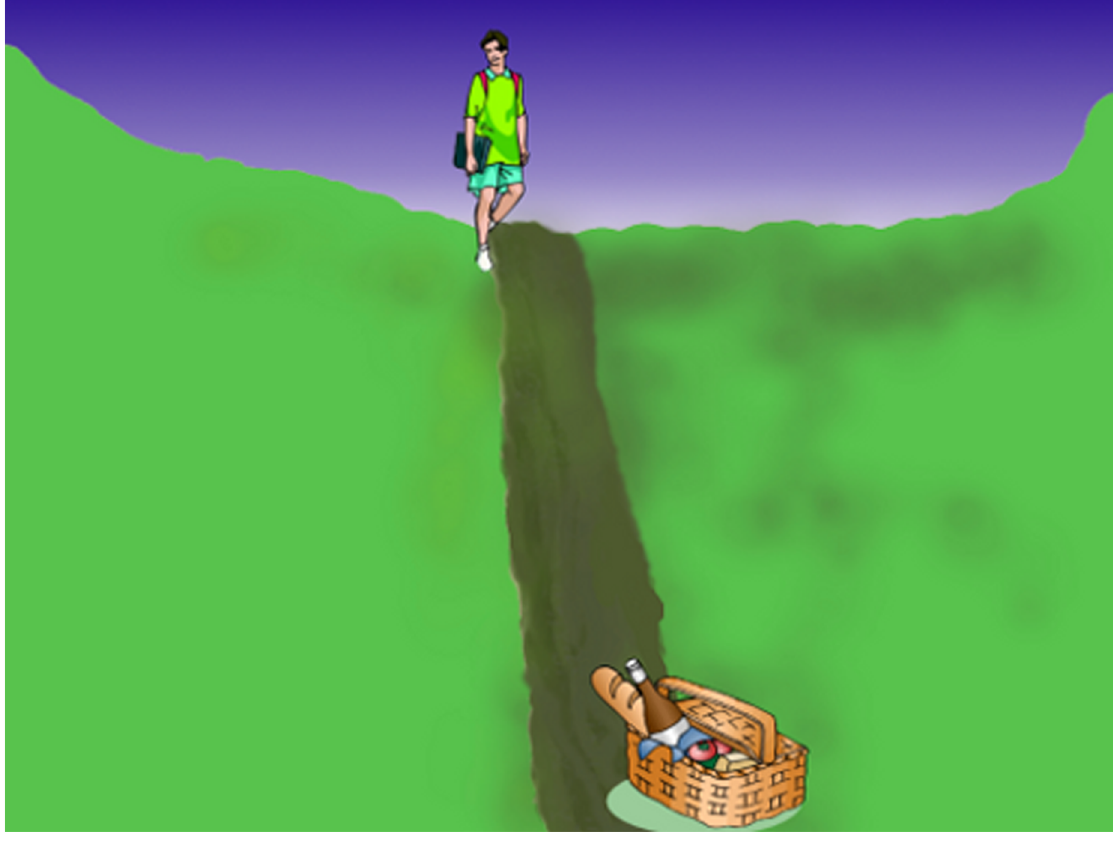
Figure 1. Example scene for the fast/slow sentences: ‘‘The student will run/stagger along the trail to the picnic basket’’.